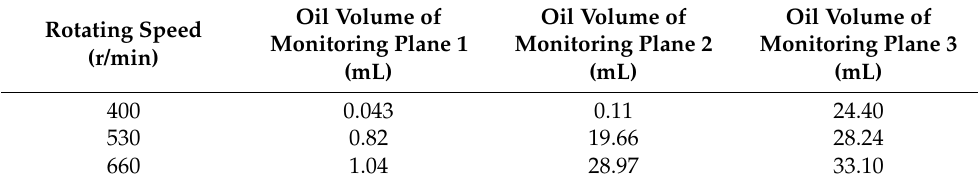
Table 2. Total oil volume through the monitoring planes versus rotational